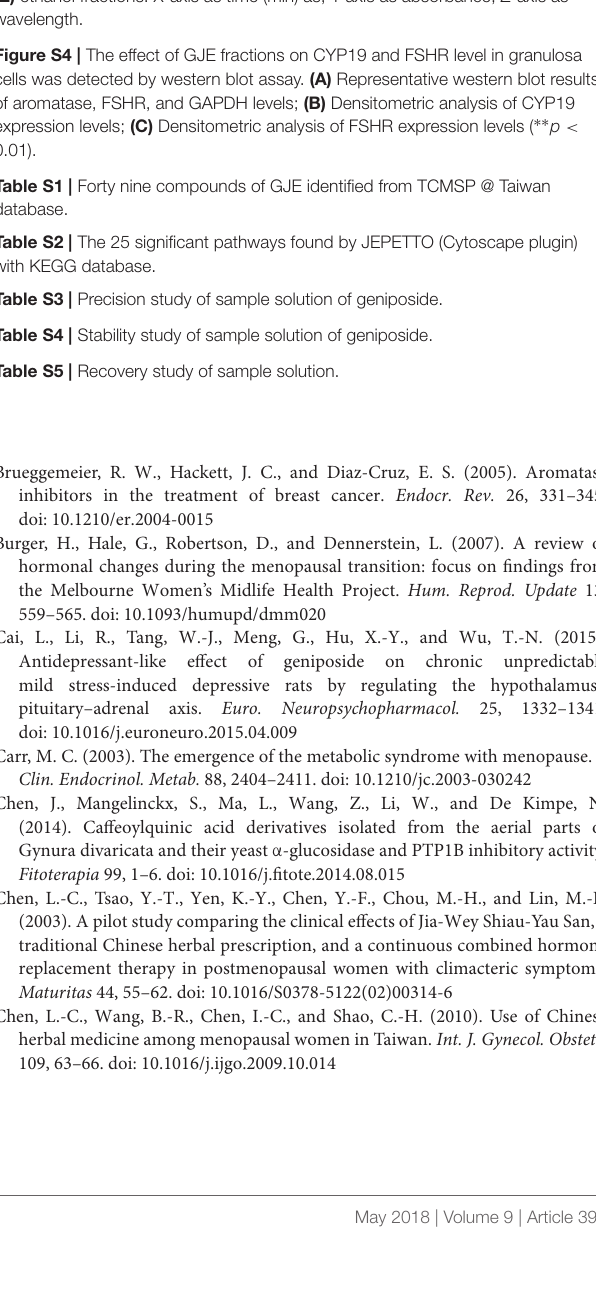
Figure S1 | Flow chart of extraction procedure for GJE bioactive fractions. Figure S2 | HPLC standard curve of geniposide. The regression equation of standard constituents is Area = 85.36C-164.88. The standard constituents showed a good linearity ( R 2 = 0.999643) with the linear range 62.5–1000 µ g/ml. Figure S3 | 3-D chromatogram of geniposide from sample solution. (A) petroleum fractions; (B) ethyl acetate fractions; (C) n-butanol fractions; (D) water fractions; (E) ethanol fractions. X-axis as time (min) as, Y-axis as absorbance, Z-axis as wavelength. Figure S4 | The effect of GJE fractions on CYP19 and FSHR level in granulosa cells was detected by western blot assay. (A) Representative western blot results of aromatase, FSHR, and GAPDH levels; (B) Densitometric analysis of CYP19 expression levels; (C) Densitometric analysis of FSHR expression levels ( ∗∗ p < 0.01). Table S1 | Forty nine compounds of GJE identified from TCMSP @ Taiwan database.